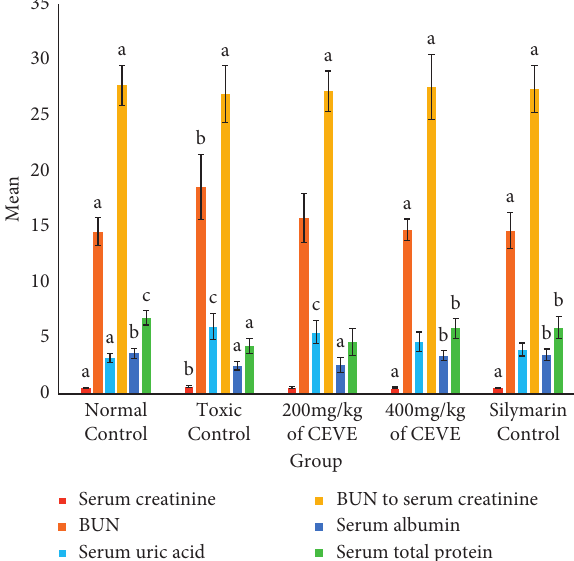
Figure 1: Serum creatinine, BUN, uric acid, BUN to serum creatinine ratio, serum albumin, and total protein levels of experimental animals. The results were expressed as mean ± standard error (SE). Values with different letters (superscript) within the same color bar across different groups are statistically significant ( P < 0 . 05), i.e., “a” superscript-containing groups are statistically significantly different as compared to “b” and “c” superscripts-containing groups within the same color bar across different groups.